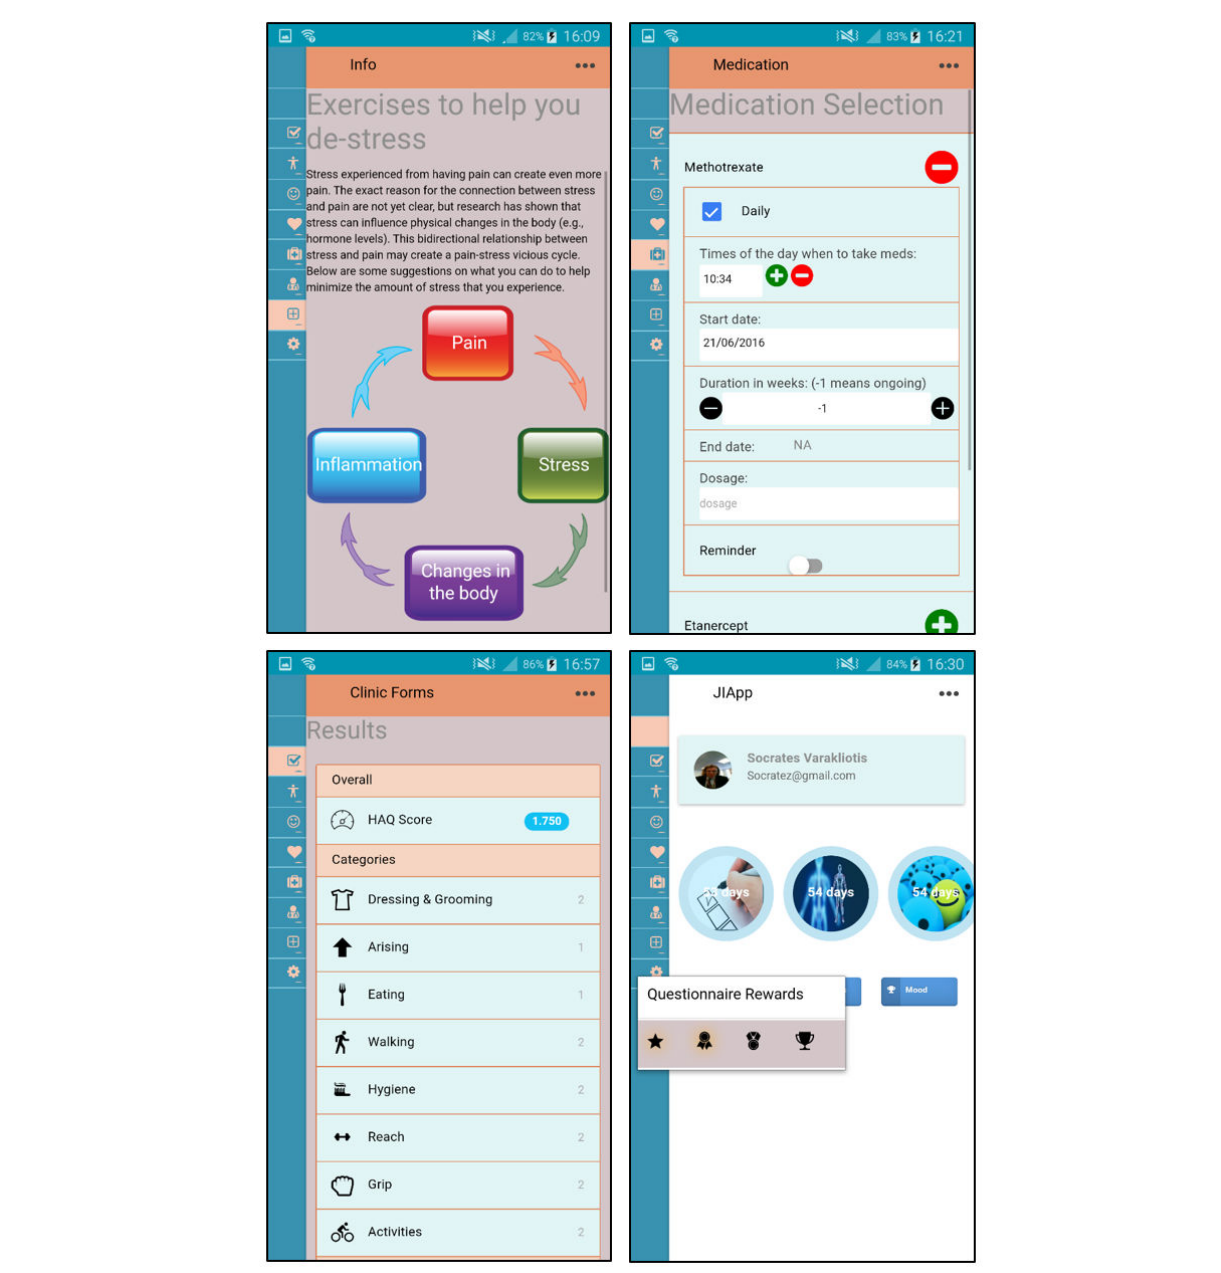
Figure 4. Screenshots of the app for adherence and